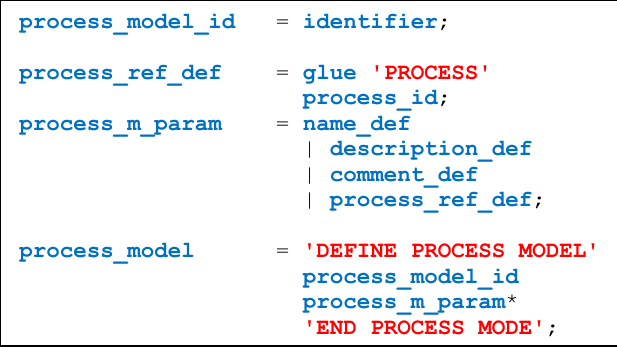
Fig. 6. Process model definition in the proposed DSL language.